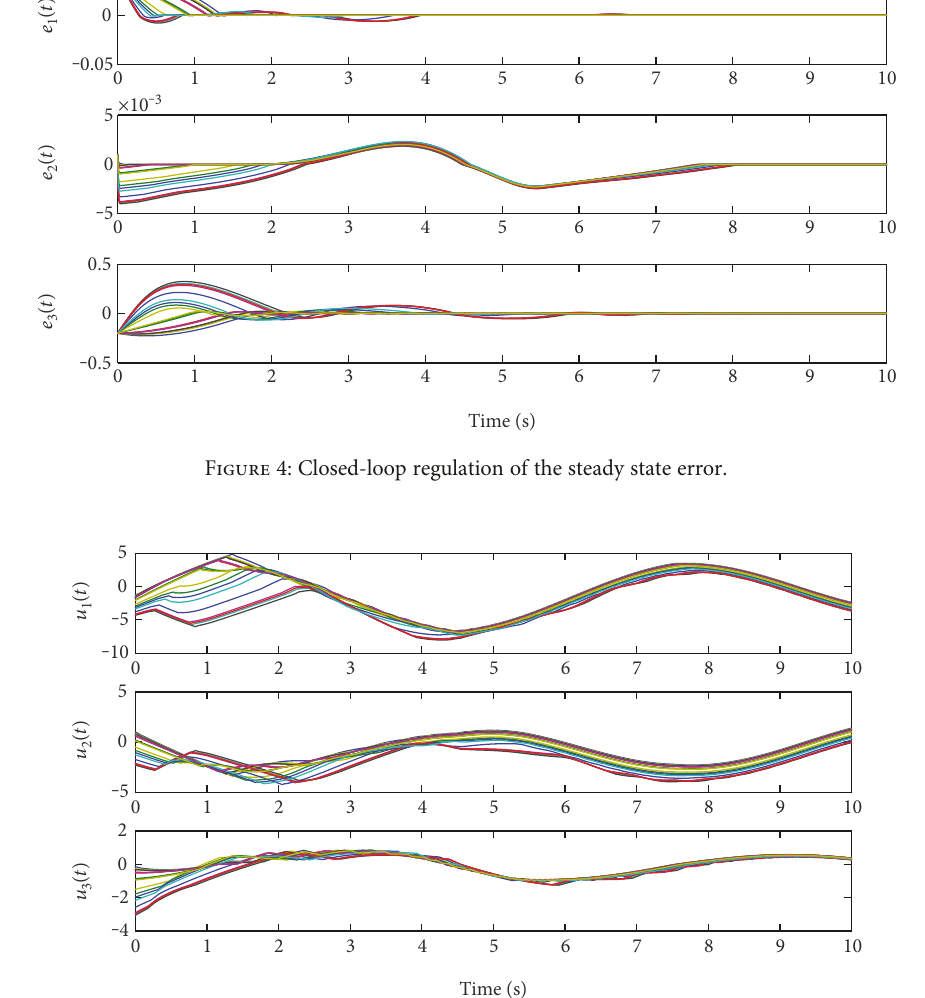
t , u t , and u t ) during closed-loop operation. 1 2 3